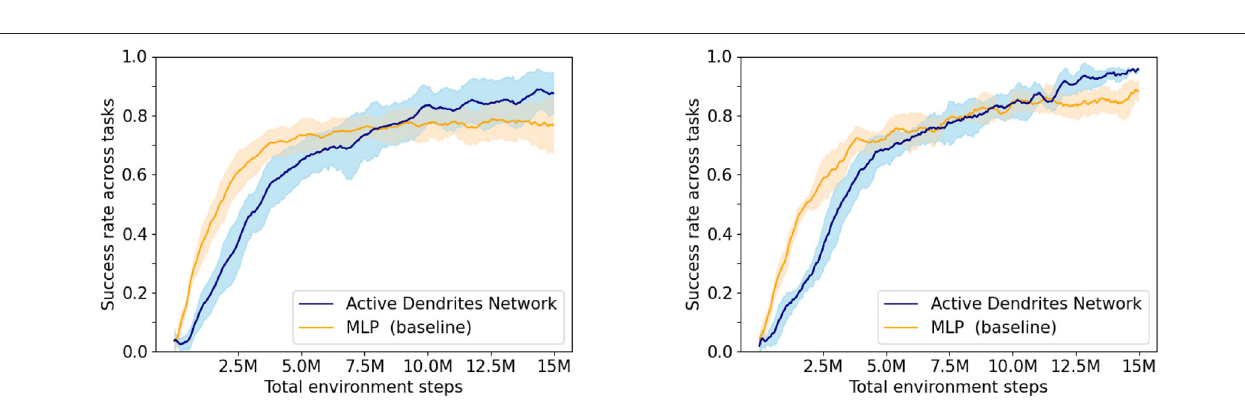
FIGURE 5 | The success rate of our network when learning 10 tasks compared to the MLP baseline with context. (Left) Experiment 1—the average of 10 Active Dendrites Network runs and 10 MLP baseline network runs that all share the same training hyperparameters. (Right) Experiment 2—the average of the five best Active Dendrites Network experiments and the five best MLP baseline experiments. The shaded region in each plot represents the standard deviation of the success rate from the